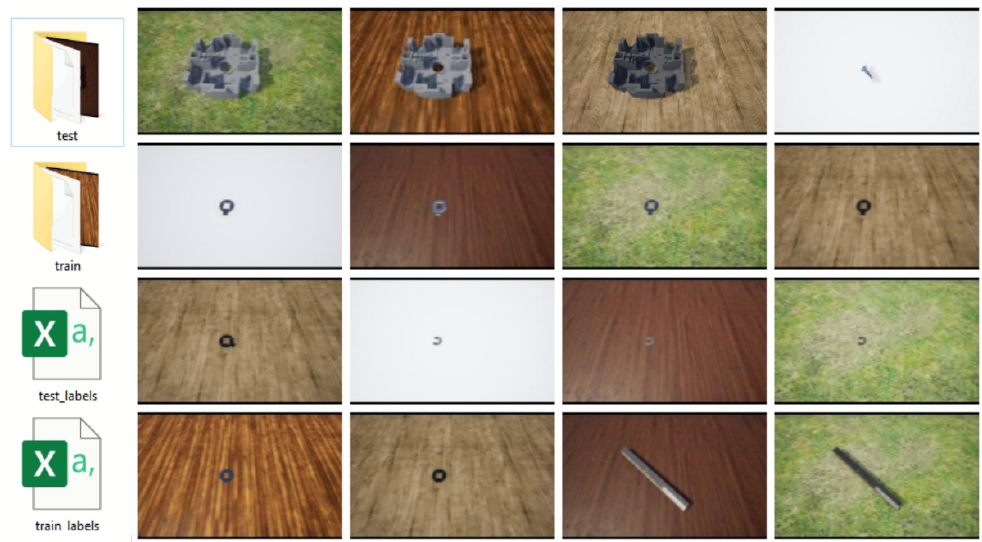
( c ) Figure 10. An autogeneration of the part localization by OpenCV for Segmentation: ( a ) the input image with black back- ground from the Unreal Engine; ( b ) the result of OpenCV algorithm for precise contour generation; ( c ) an example of manual contour selection in VGG Image Annotator. XML format for SSD is accepted as standard, but instance segmentation has many formats, COCO JSON, CSV, LabelMe JSON, RLE, etc. The simplest JSON structure has LabelMe format with polygon shape, which can be easily implemented to the automated process of contour annotation by OpenCV. An automated contour detection by OpenCV can provide a better contour as a manual process and it can significantly improve CNN instance segmentation after the training process, as can be seen in Figure 11. ( a ) ( c ) Figure 11. OpenCV detected contour representation: ( a ) binarized image; ( b ) all detected points; ( c ) reduced number of